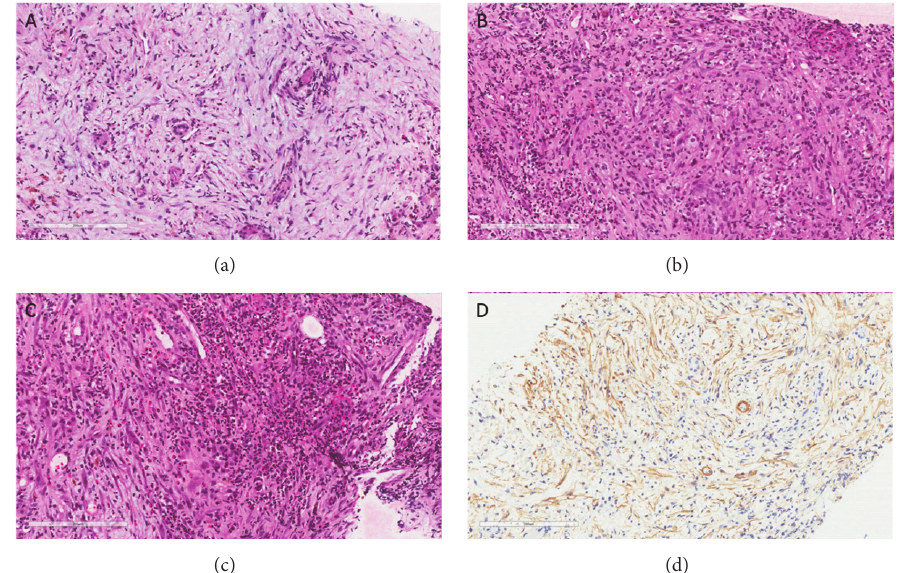
Figure 2: Pseudotumour histology. The H&E images (a, b, c) show a loose proliferation of fibrous tissue, accompanied by a mixed acute and chronic inflammatory infiltrate, showing entrapment of residual bile ducts and hepatic artery branches. The immunohistochemistry (d) test for smooth-muscle actin shows reactivity in spindle cells, consistent with a proliferation of myofibroblasts, as might be seen in reactive fibrosis or an inflammatory